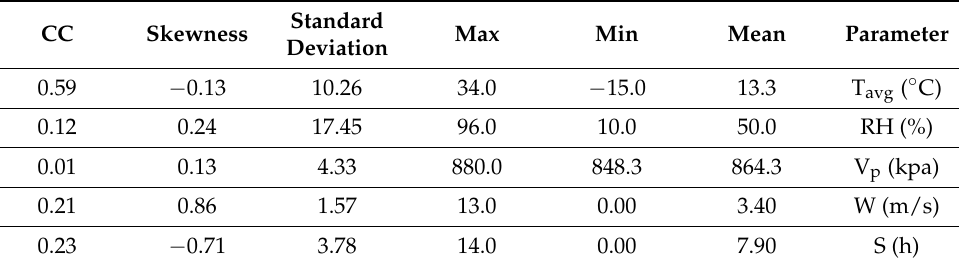
Table 2. Statistical characteristics of the meteorological data.